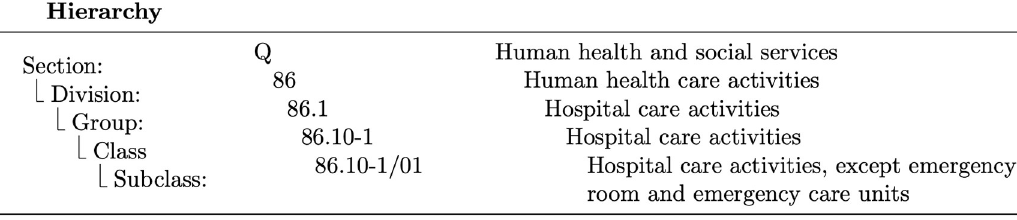
Fig 2. CNAE’s structure example—Human health and social